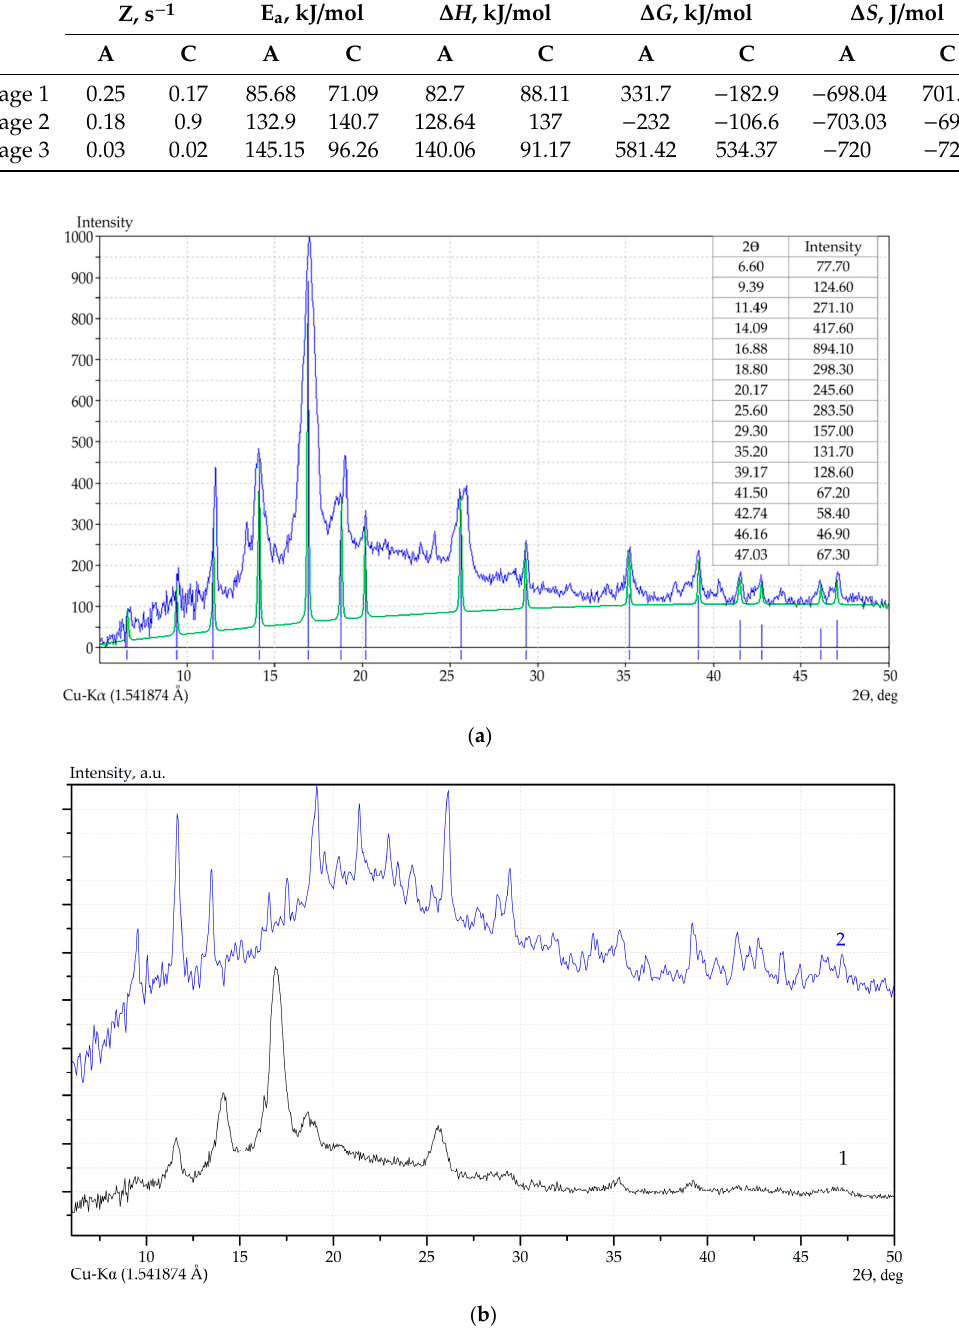
Figure 1. XRD pattern for copper trimesinate synthesized according to A (a), B (curve 1, b) and C (curve 2, b) methods